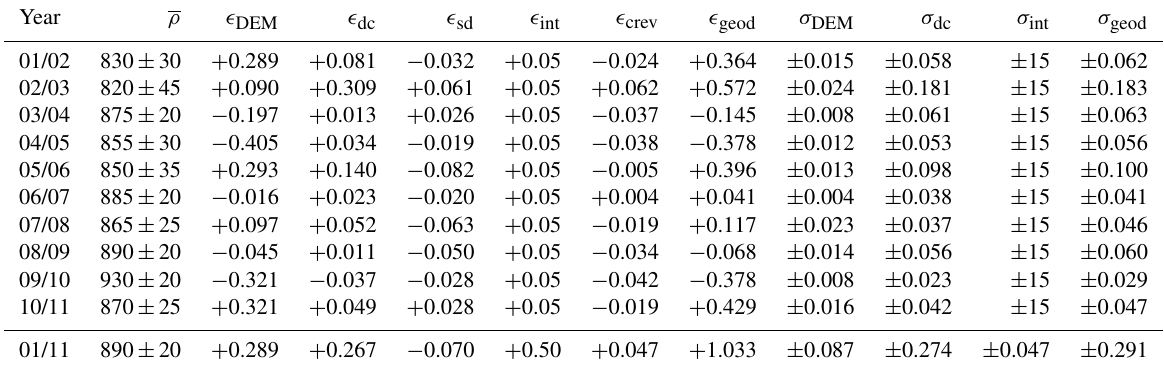
Table 3. Method-inherent differences and uncertainties as quantified in this study. Differences related to DEM ( (cid:15) DEM and σ DEM ), density conversion ( (cid:15) dc and σ dc ), survey dates ( (cid:15) sd ), internal processes ( (cid:15) int and σ int ), and crevasse volume ( (cid:15) crev ). While the overall (cid:15) geod accumu- lates from all individual differences, the overall σ geod is calculated by propagating the individual uncertainties. The unit for ρ is kgm − 3 . All mass balance uncertainties are given in metre water equivalent (mw . e .